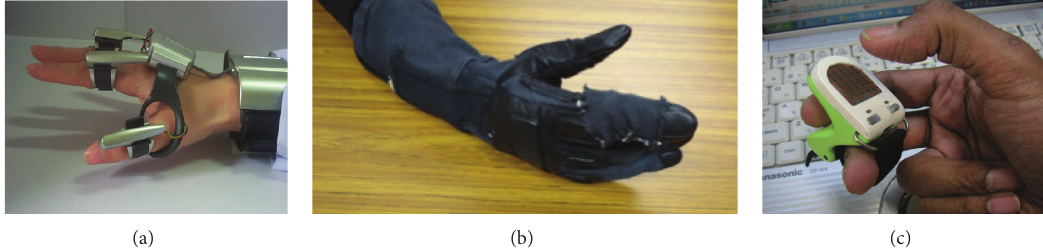
Figure 6: More wearable pointing devices. (a) A user wearing the wrist and finger attachments of the SCURRY . (b) A user wearing the G3 . (c) A user holding the CUPID-MZ . (a)–(c) from [21, 23, 24],